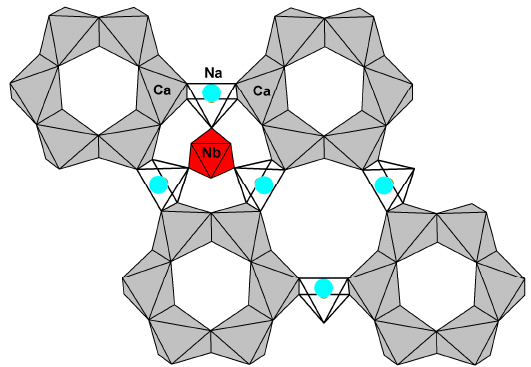
Figure 7. The local situation around M 2 Na-centered semioctahedra (square pyramids) in the structure of Sample 9 (Table 4) [2].